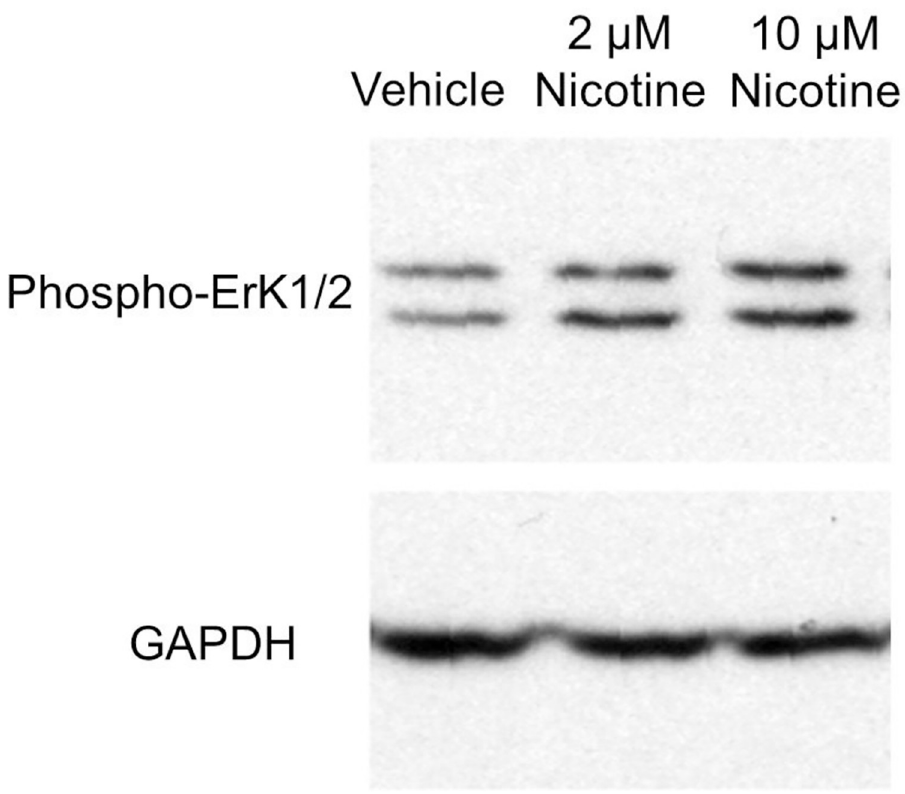
Fig 2. Nicotine activated Erk1/2 in A549 cells. A549 cells were treated with nicotine or vehicle for 48 hours, showing that nicotine induced Erk1/2 phosphorylation. GAPDH was analyzed as a loading